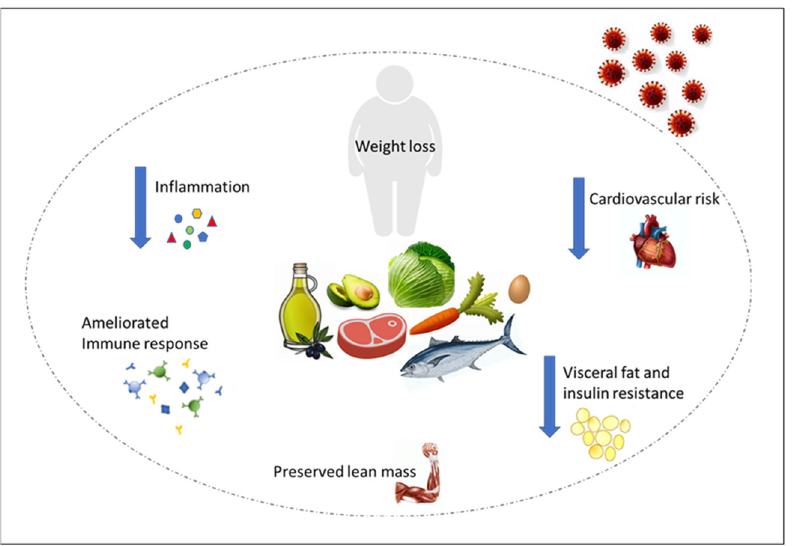
Figure 1. Mechanisms through which VLCKD with its consequent weight loss may reduce the susceptibility to severe SARS-CoV-2 infection and stem the damage induced by the virus.